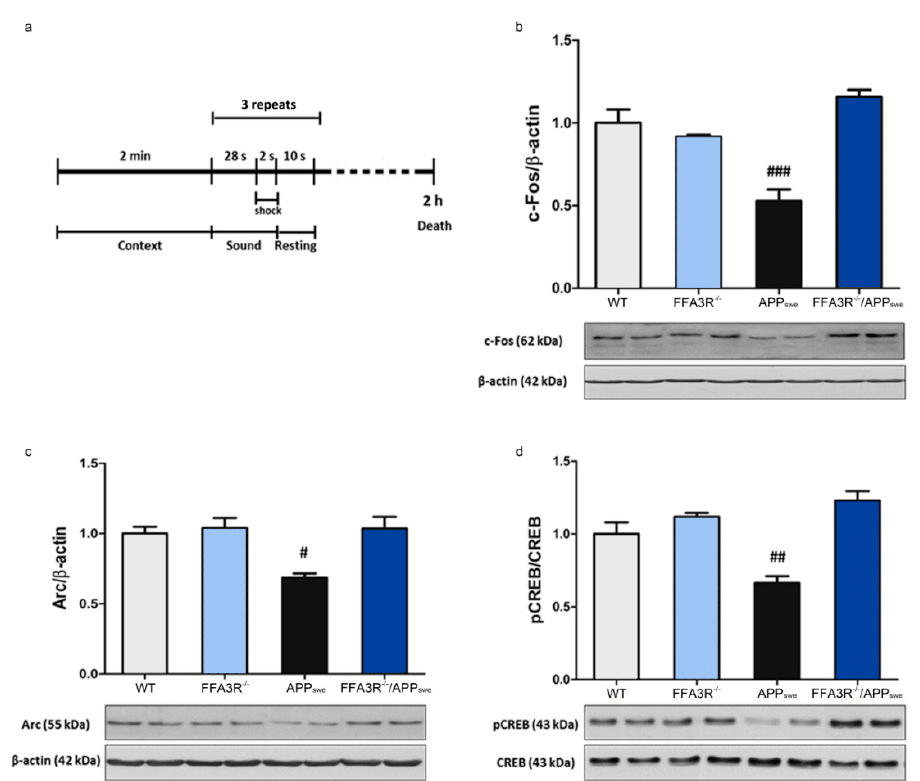
Figure 6. Induction of memory-associated genes in hippocampal mice samples. ( a ) Scheme show- ing the fear conditioning training. The levels of IEGs were analyzed in WT, FFA3R − / − , APP swe , and FFA3R − / − /APP swe mice by Western blot. We show a representative blot and the quantification of immunoreactive bands for each protein. The results are expressed as the mean ± SEM (n = 6), and the bars represent the ratio of c-Fos vs. β -actin ( b ), the ratio of Arc vs. β -actin ( c ), and the ratio of pCREB vs. CREB ( d ) normalized to the ratio of WT mice. # p < 0.05, ## p < 0.01, ### p < 0.001 vs. WT.